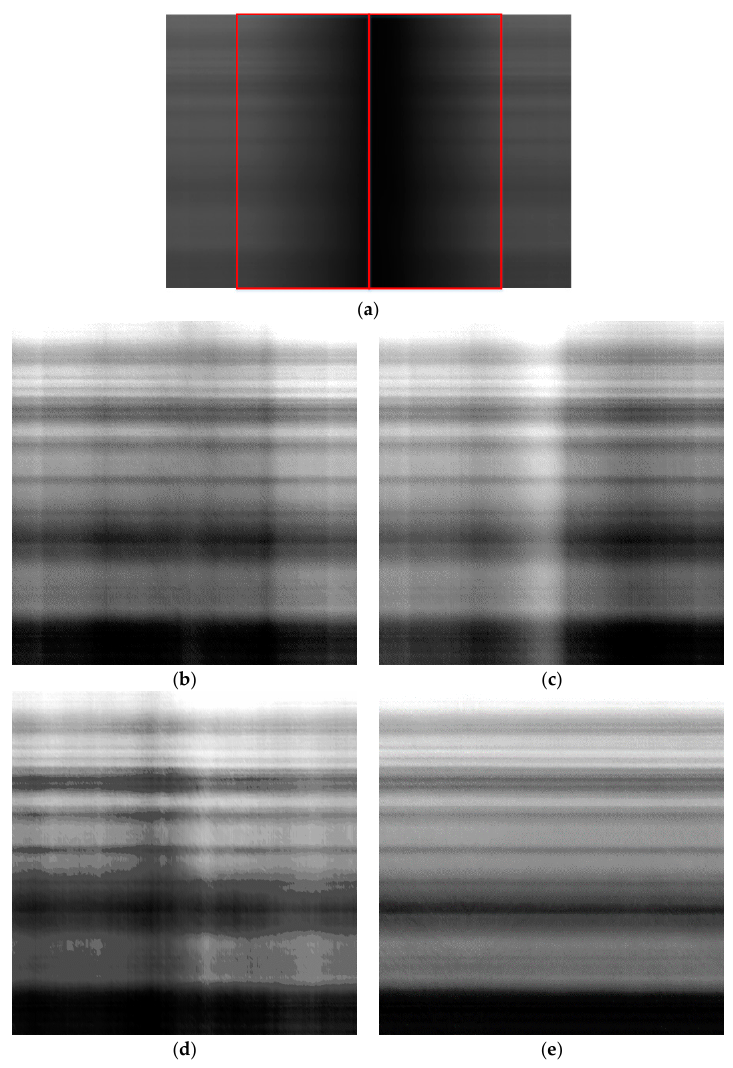
Figure 11. Corrected images of the low-brightness region of the side-slither data (the images were stretched for display): ( a ) raw data for the low-brightness region; ( b ) results obtained using polynomial fitting; ( c ) results obtained using laboratory coefficients; ( d ) results obtained using the on-orbit coefficients; ( e ) results generated using coefficients obtained by the proposed method.